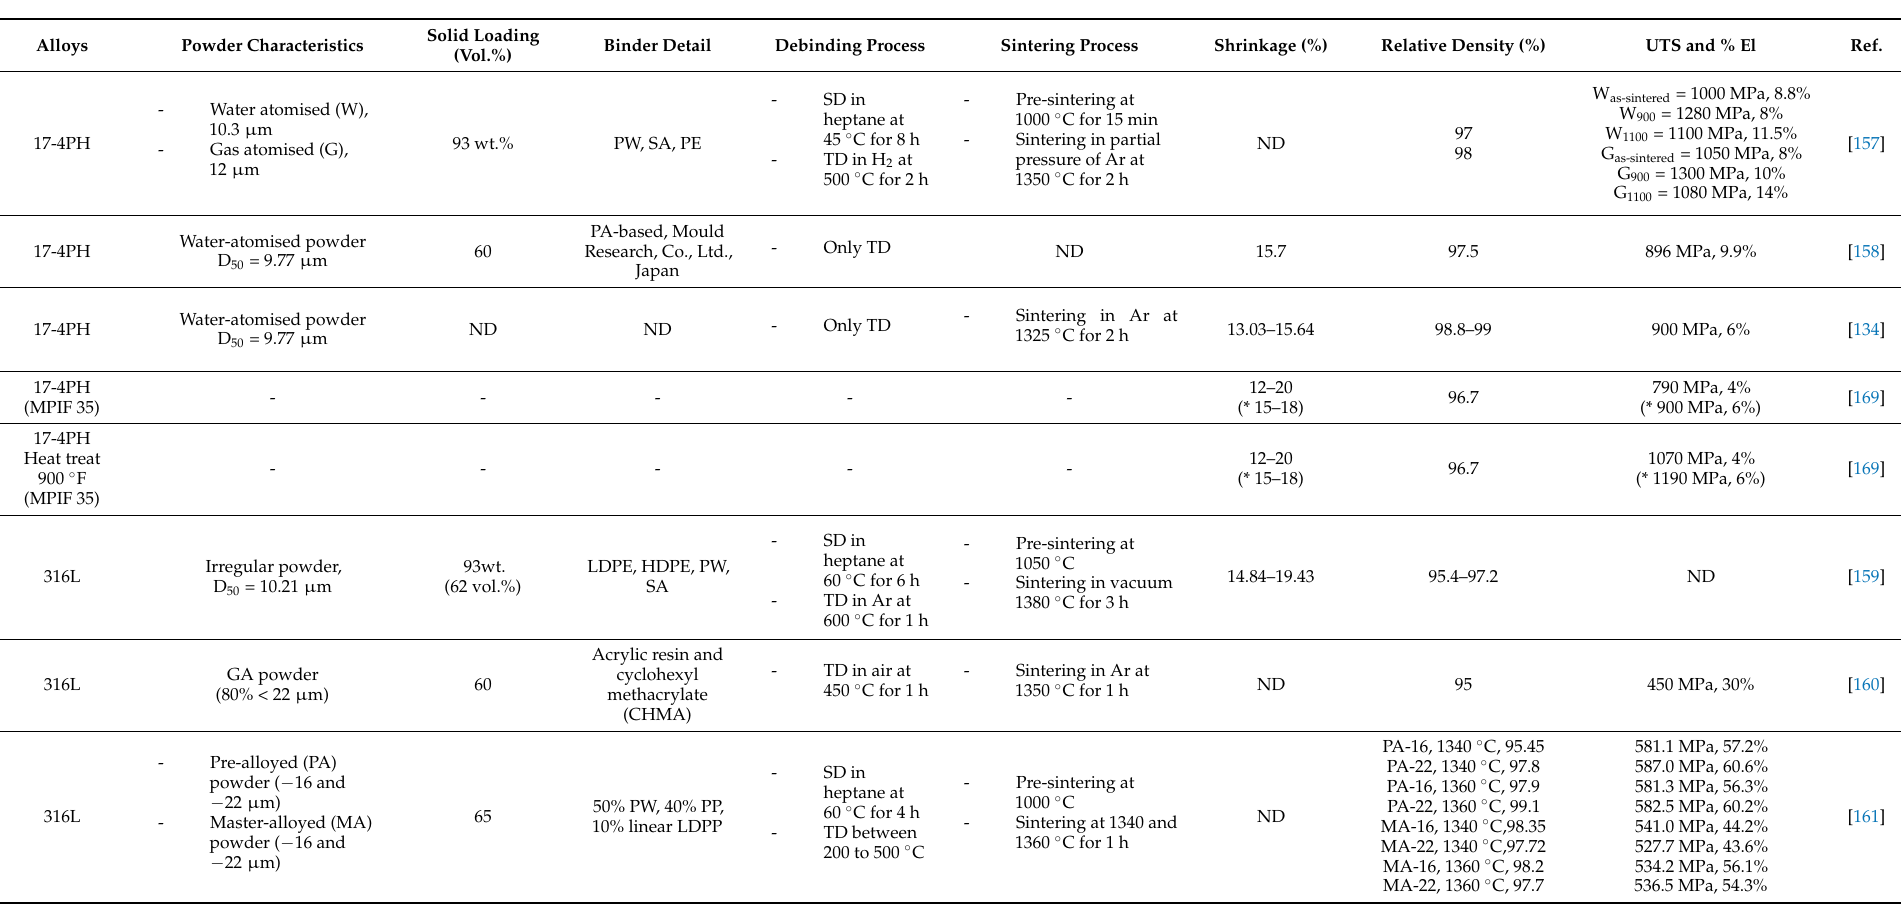
Table 2. Selected MIM information categorised by alloys and used for comparison in this study (ND is no detail; SD is solvent debinding; TD is thermal debinding, MPIF35 is Metal Powder Industries Federation Standard 35 Metal Injection Moulding Materials; JPMA is Japan Powder Metallurgy Association Standard Metal Injection Moulding Materials; * typical